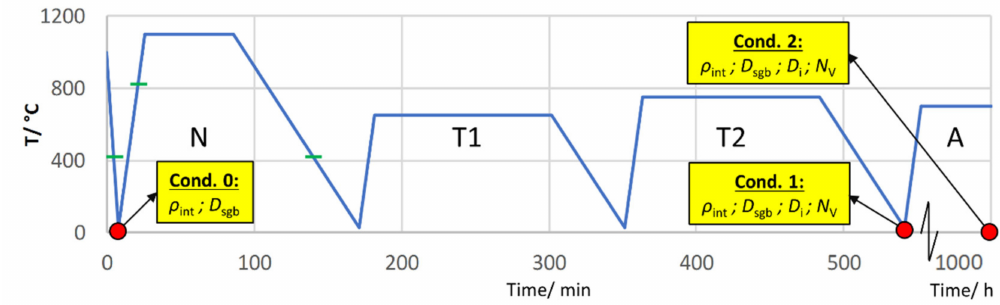
Figure 2. Investigated sample conditions and microstructural features of